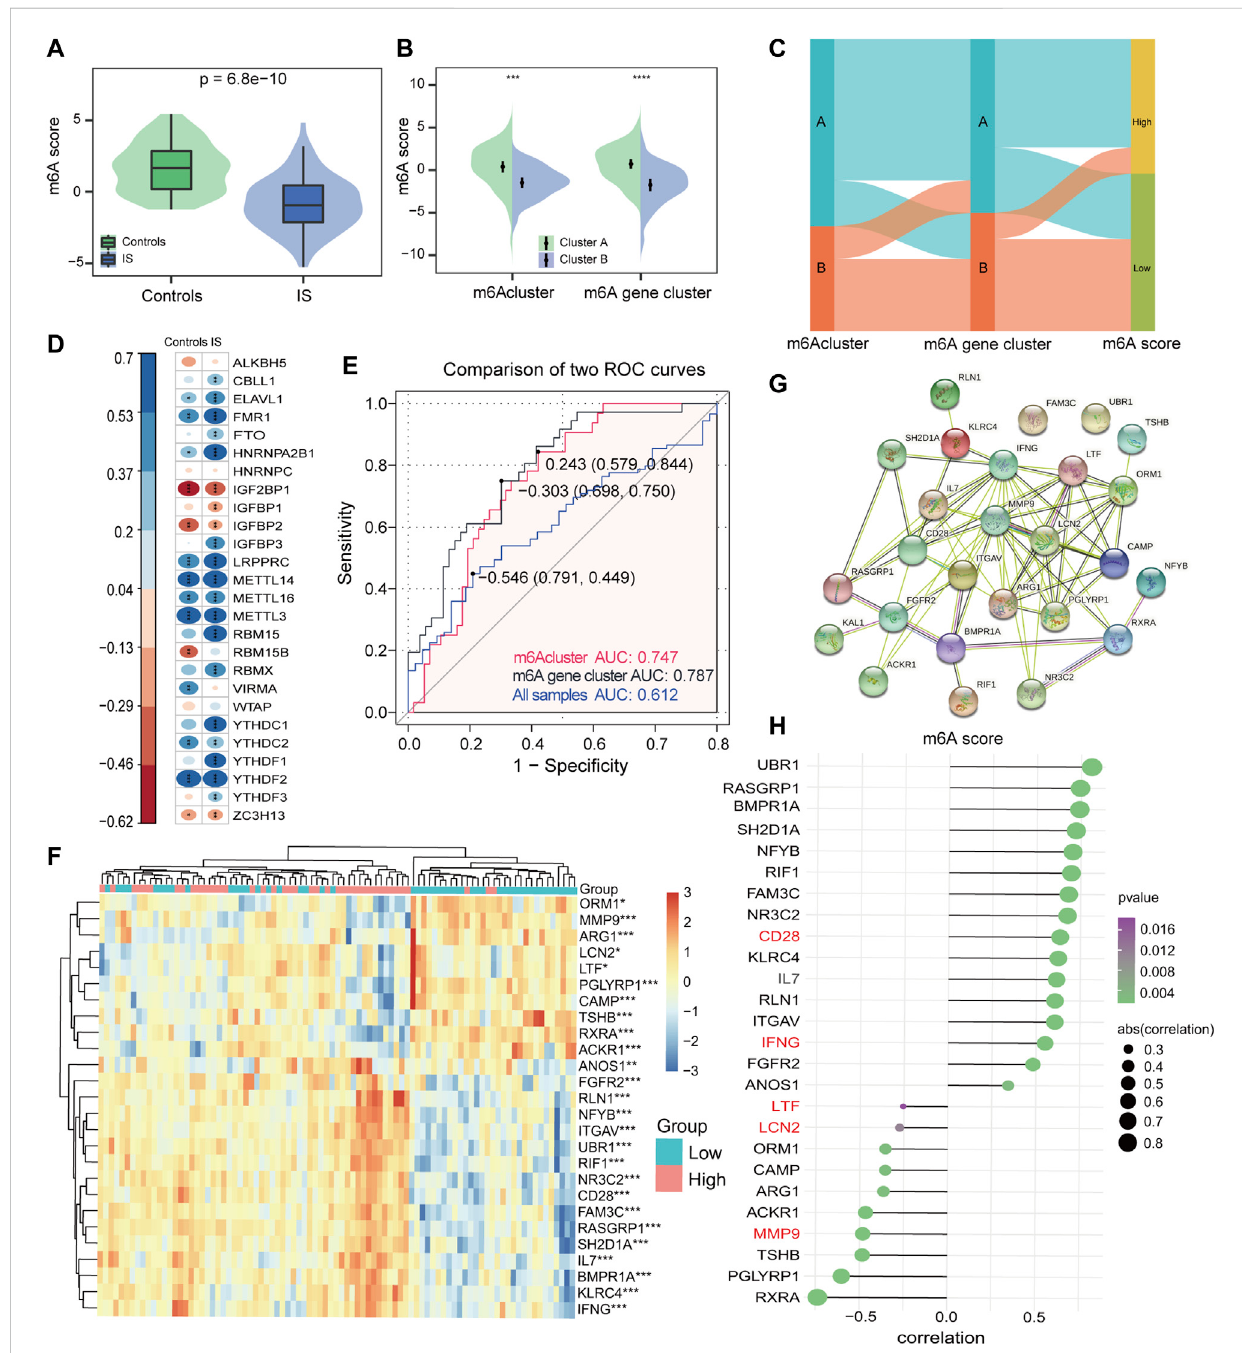
FIGURE 7 Constructionofthem6Ascoresignature. (A) Differencesinm6AscorebetweencontrolsandISsamples( p =6.8*e − 10 ). (B) Differencesinm6Ascorebetween twom6Aclustersandtwom6Ageneclusters.Wilcoxontestwasappliedtocomparethestatisticalvariations. (C) Sankeydiagramshowingtherelationshipamong m6Aclusters, m6A gene clusters, and m6A score. (D) Correlations between m6A score and m6A regulators among controls and IS samples. (E) Discrimination abilityofm6Ascoreforbothm6Aclustersandm6AgeneclusterswasassessedbyAUCvalues. (F) HeatmapofIRsbetweenhighandlowm6Ascoregroups. (G) PPI network of IRs. (H) Correlation of IRs with m6A score. * p < 0.05, ** p < 0.01, and *** p < 0.001, “ ns ” indicates no signi fi